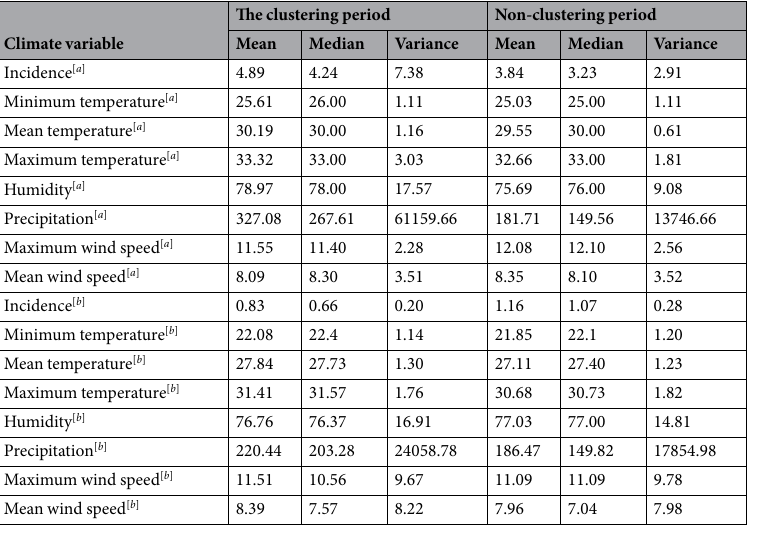
Table 5. Description on the incidences and climatic factors for two clustering areas. The clustering period is from May 2014 to September 2016 for the first clustering area, and is from June 2013 to November 2015 for the second clustering area. The other period denotes the period from 2012 to 2016 except the clustering period. We let [a] denote climate variables for the first clustering area, and let [b] denote variables for the second clustering